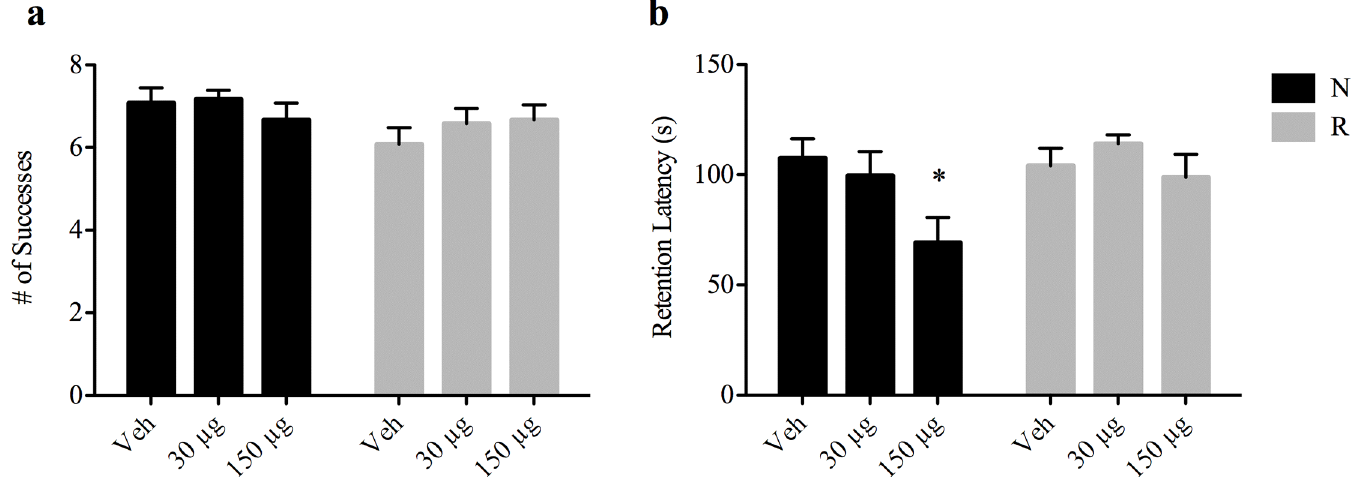
Fig 2. Effect of iron supplementation on cognitive development. ( a ) T-maze test scores at PD35. Scores betweenN-veh and R-veh groups were not significantly different (7.08 ± 0.36 successes vs. 6.08 ± 0.40 successes, p = 0.08) and no differences were found in scores betweentreatment groups. ( b ) Passive avoidancetest at PD40. Data is expressedas time (s) taken to enter the dark chamberon d2 of the test, designated as retention latency. Latency was significantly decreased in N-150 μ g pups compared to the Veh controls (107.54 ± 8.73 s vs. 69.14 ± 11.55 s, * p < 0.05, one-wayANOVA). Data are presented as means ±